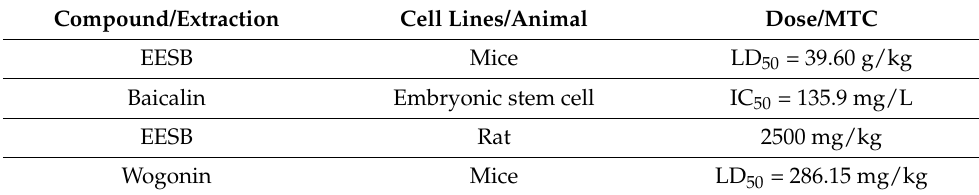
Table 2. Toxicity and side effects of Scutellaria baicalensis